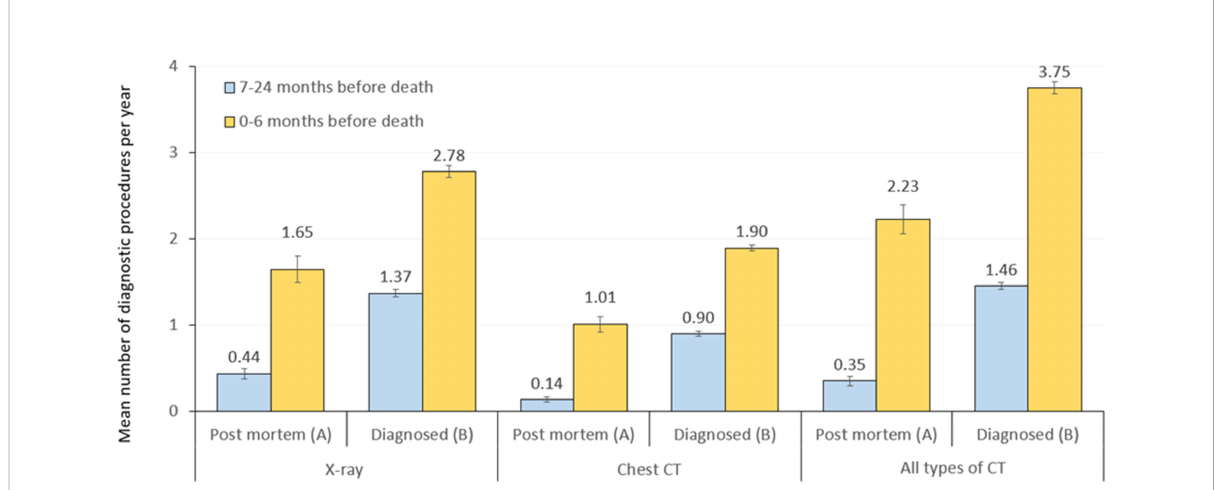
FIGURE 3 Mean annual number of X-ray, chest CT or all types of CT scans within 7 – 24 months (blue) and 6 months (yellow) before the time of death among patients diagnosed with LC post-mortem (population A ) or during their lives (population B ). LC, lung cancer.